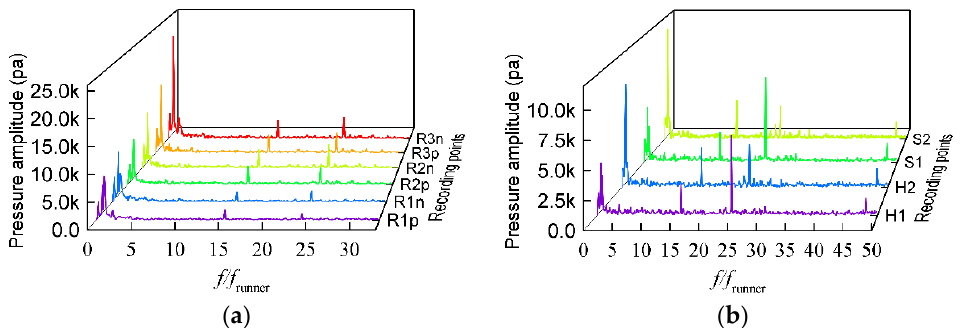
Figure 12. Spectral analysis of the pressure signals of the ten recording points in the runner (16 deg GVO): ( a ) in the runner blade and ( b ) in the runner hub and shroud.